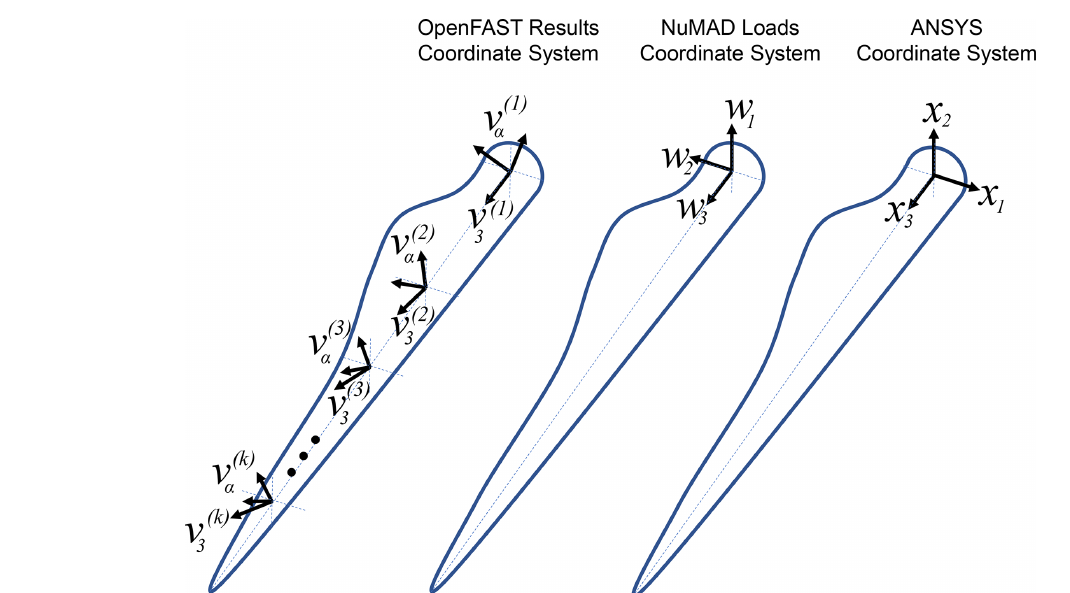
Figure 2. Comparison of the FAST results’ coordinate system with that of the NuMAD and ANSYS coordinate systems.